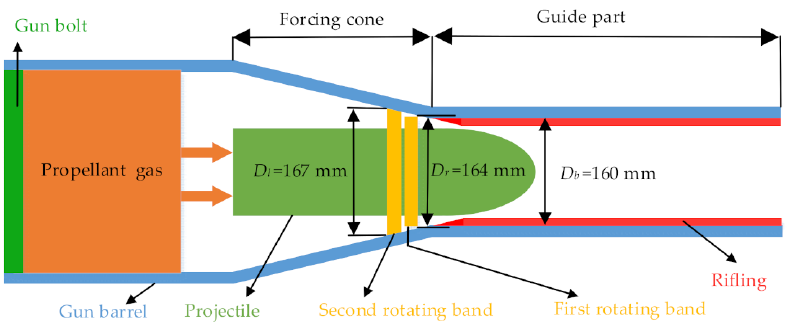
Figure 3. Exhibition of the size comparison between D r , D l and D b .